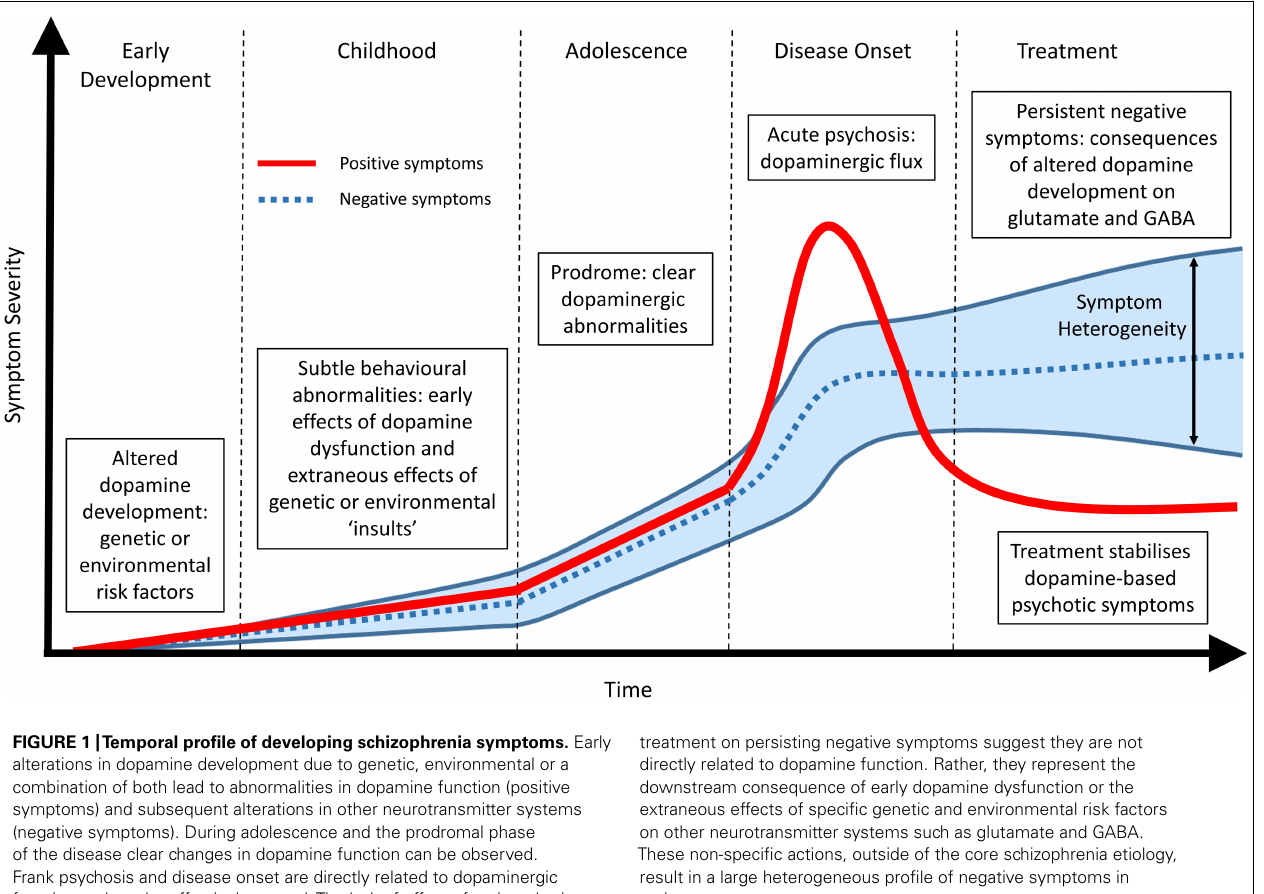
FIGURE 1 |Temporal profile of developing schizophrenia symptoms. Early alterations in dopamine development due to genetic, environmental or a combination of both lead to abnormalities in dopamine function (positive symptoms) and subsequent alterations in other neurotransmitter systems (negative symptoms). During adolescence and the prodromal phase of the disease clear changes in dopamine function can be observed. Frank psychosis and disease onset are directly related to dopaminergic function and can be effectively treated.The lack of effect of antipsychotic